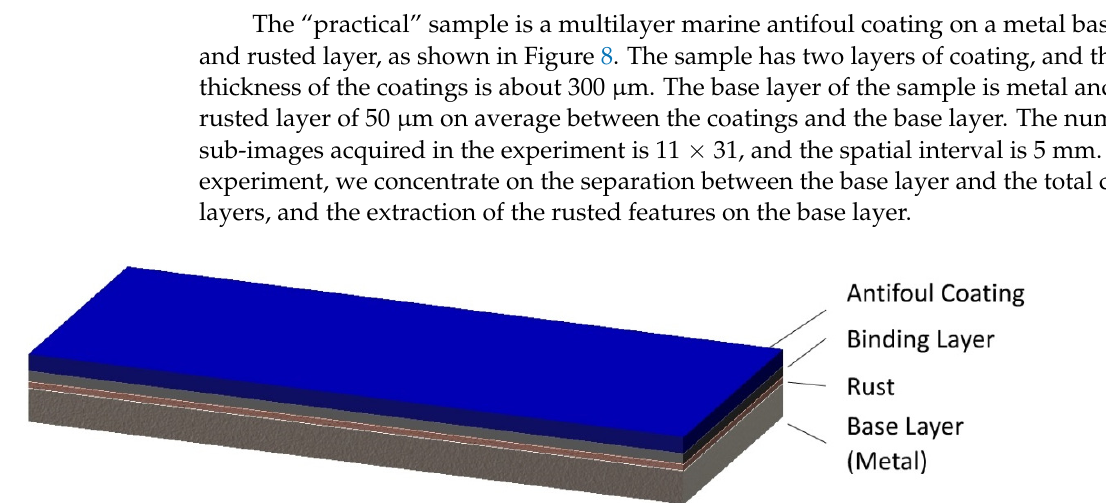
Figure 8. The structure of the “practical” sample of marine antifoul coating used in the experiment.